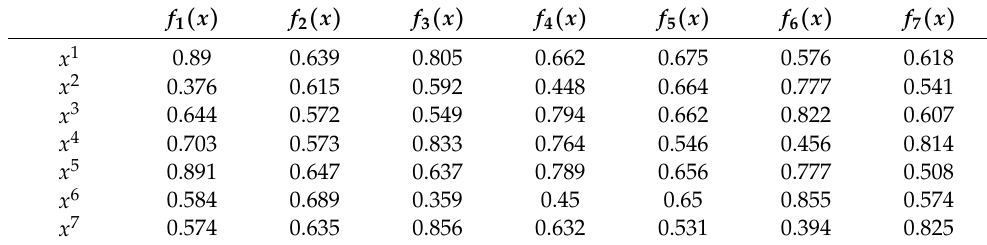
Table 4. Normalized decision matrix for the given example.